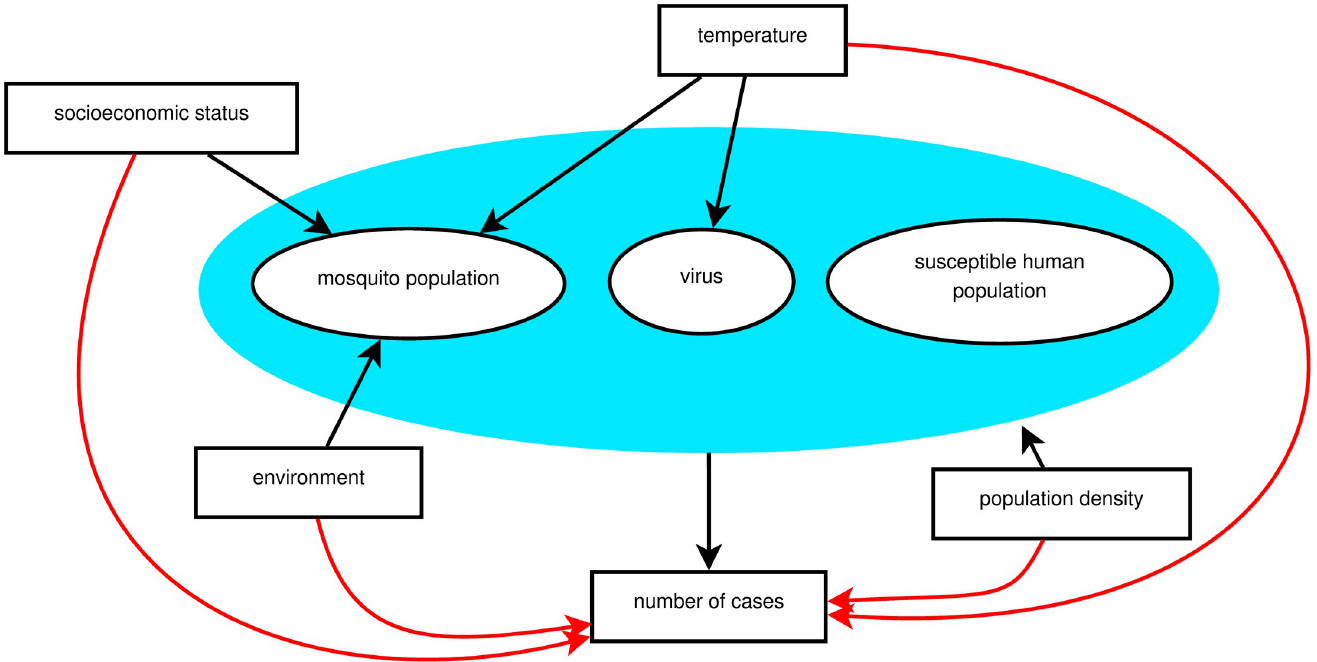
Fig 1. A theoretical model for a chikungunya epidemic in a given region. Direct associations are represented by black arrows and indirect associations by red arrows. The blue area includes the necessary elements for the epidemic to occur.